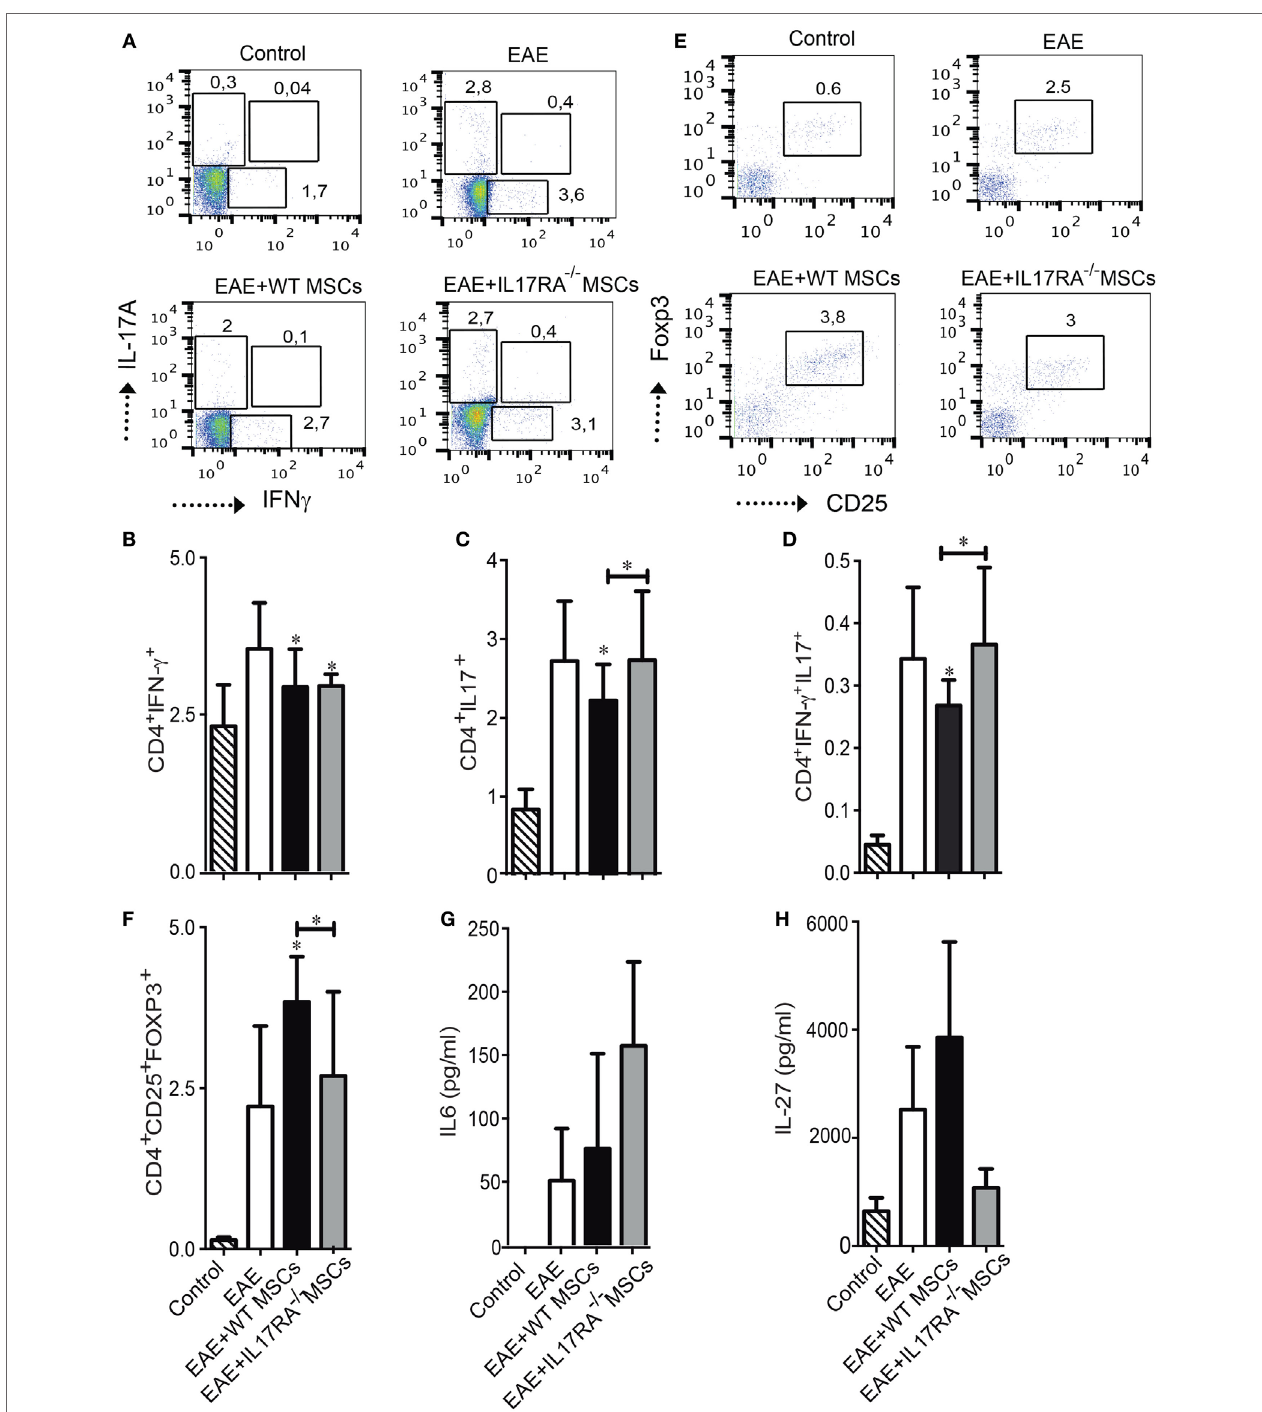
FigUre 5 | Mesenchymal stem cells deficient for IL17RA failed to reduce the frequency of Th17 cells and to induce Treg generation after administration in experimental autoimmune encephalomyelitis (EAE) mice. (a) Representative dot plots of CD4 + T cells positive for IL17A and IFN γ in the draining lymph node (dLN) of mice of each experimental group. (B–D) Percentage of Th1 cells CD4 + IFN γ + (B) , Th17 cells CD4 + IL17 + (c) , and IFN γ + IL17 + producing CD4 + cells (D) were evaluated in the dLN of mice of the different experimental groups at day of euthanasia. (e) Representative dot plots of classical Treg cells in the dLN of mice of the different experimental groups. (F) Frequency of Treg cells (CD4 + CD25 + Foxp3 + ) was assessed in dLN at day of euthanasia. (g,h) IL6 and IL27 quantification in the blood of mice 18 days after EAE induction. Bars represent the mean ± SD. Statistical differences were calculated using an ANOVA test. * P < 0.05, ** P < 0.005, *** P < 0.0005 compared with EAE group if not indicated by a line. The results represent two independent experiments with a total of 16 mice per experimental group.